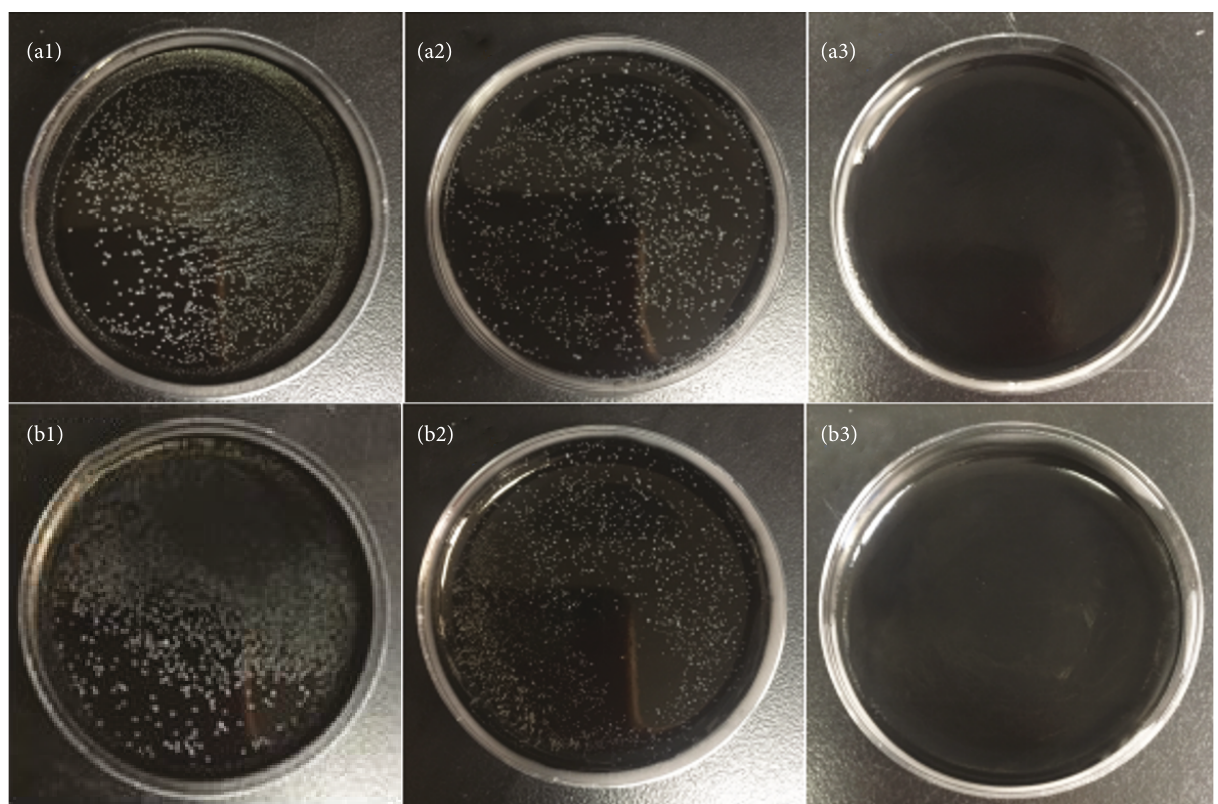
Figure 13: Antimicrobial qualitative test ((1) commercial 1; (2) commercial 2; (3) CGCe ink; (a) S. aureus ; ( b) E. coli